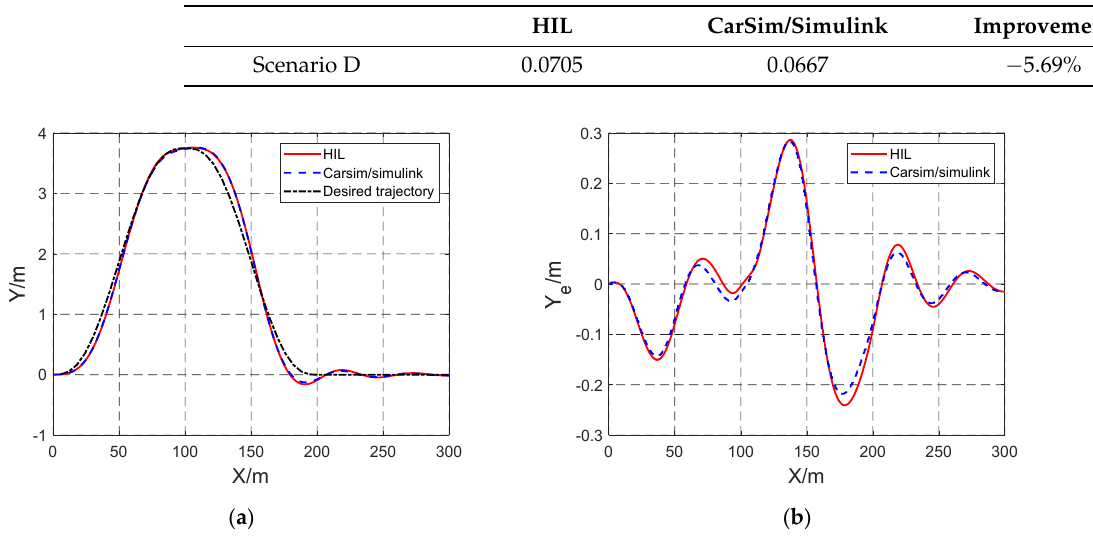
Table 7. RMSE of trajectory tracking error in Scenario D.